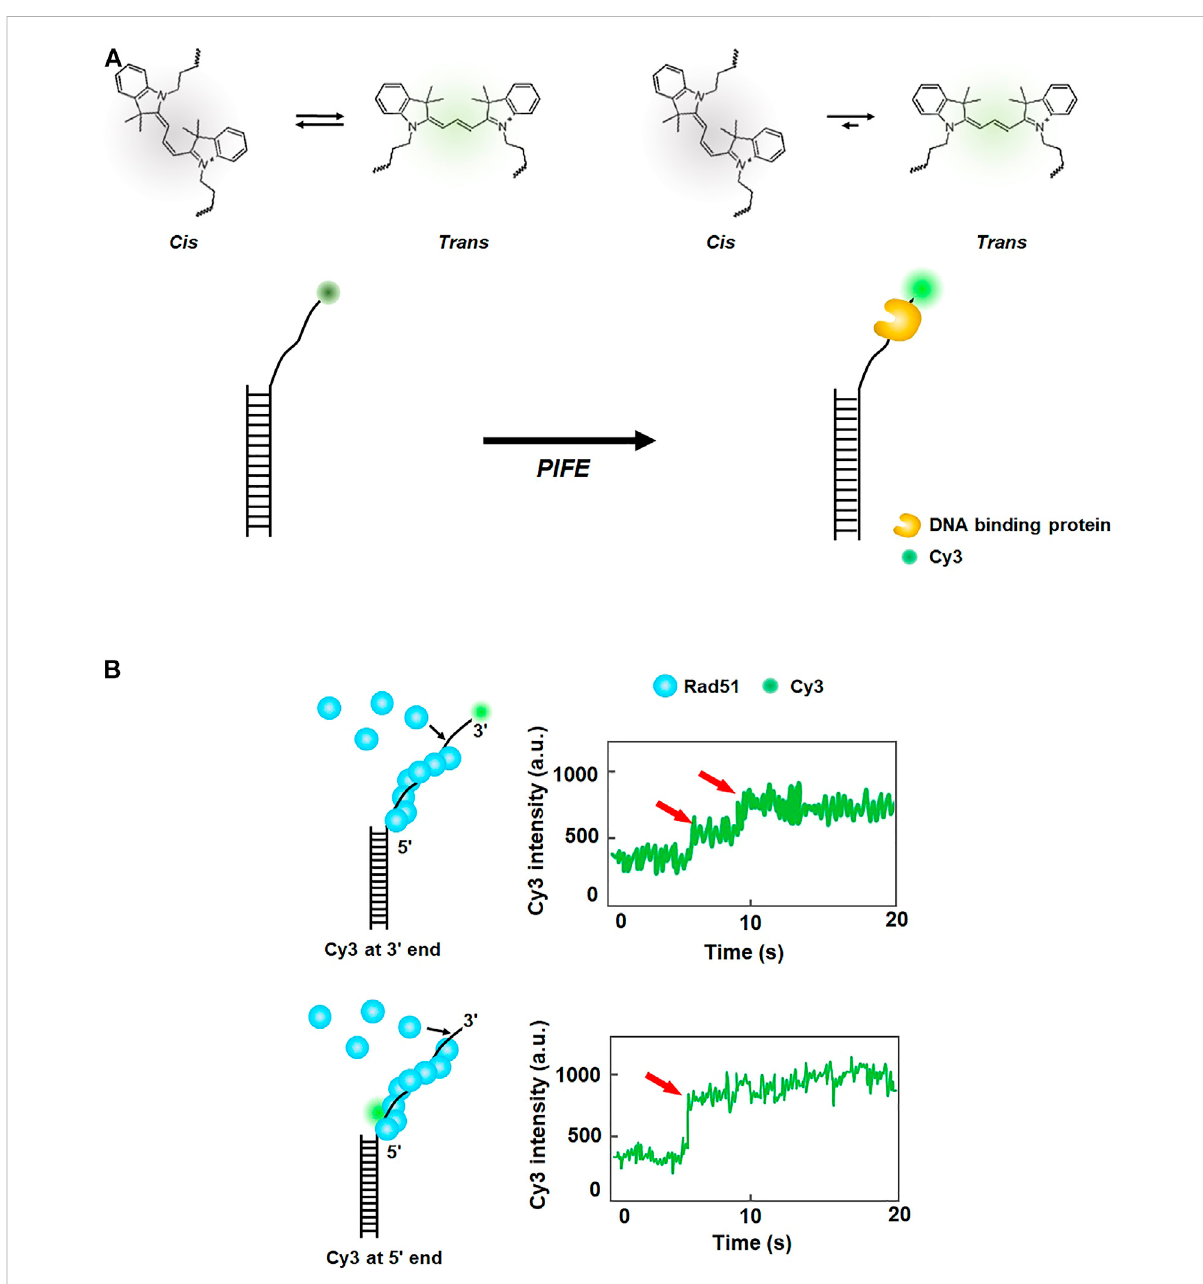
FIGURE 2 Protein-induced fl uorescence enhancement (PIFE). (A) Principle of PIFE. In the absence of a protein, the isomers of Cy3 interconvert between cis and trans states. When a DNA-binding protein is placed in the vicinity of Cy3, interaction with the protein induces transition to the trans state, which has a higher quantum yield than the cis state and enhances fl uorescence intensity. (B) Fluorescence signal change according to the labeling positionofCy3inssDNA.WhenCy3islabeledatthe3 ′ endofssDNA, fl uorescenceintensityincreasesinmultiplesteps,whileone-stepincrease in fl uorescenceisobservedwhenCy3isinternallytaggedatthe5 ′ endofssDNA,demonstratingthatgrowthoftheRad51 fi lamentproceedsfromthe 3 ′ to 5 ′ end of ssDNA. Fluorescence intensity signals are depicted based on the reference (Qiu et al.,